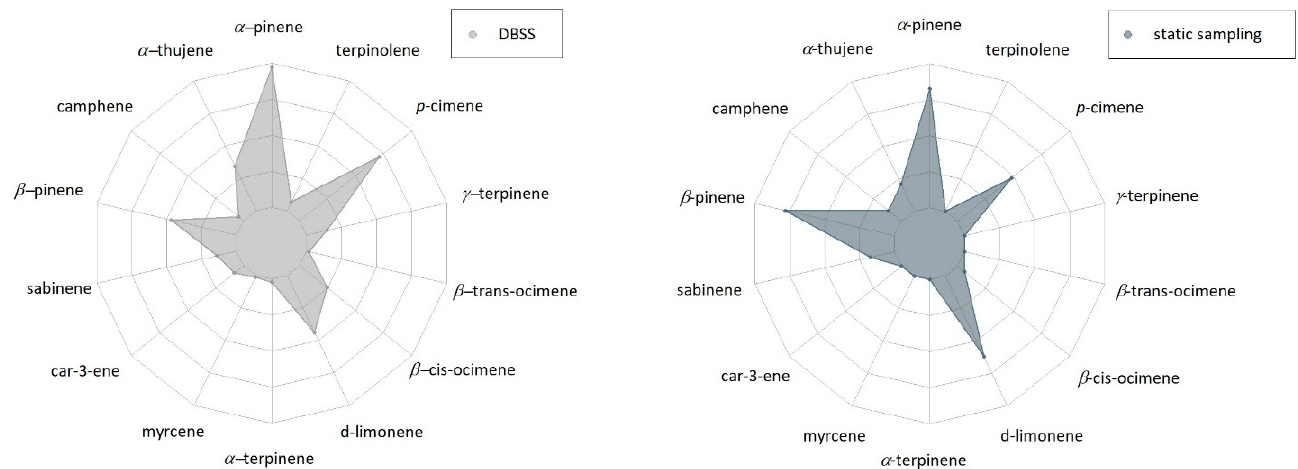
Figure 4. Radar-plots showing the results of the semi-quantitative analysis of BVOCs at sampling point 3 ( n = 3) expressed as the peak area of each individual compound. The results are split in two graphs to highlight the quantitative differences between the two sampling techniques (different scales: DBSS from 0 to 1,350,000; static sampling from 0 to 45,000). Results of statistical analysis are reported in Table S3.